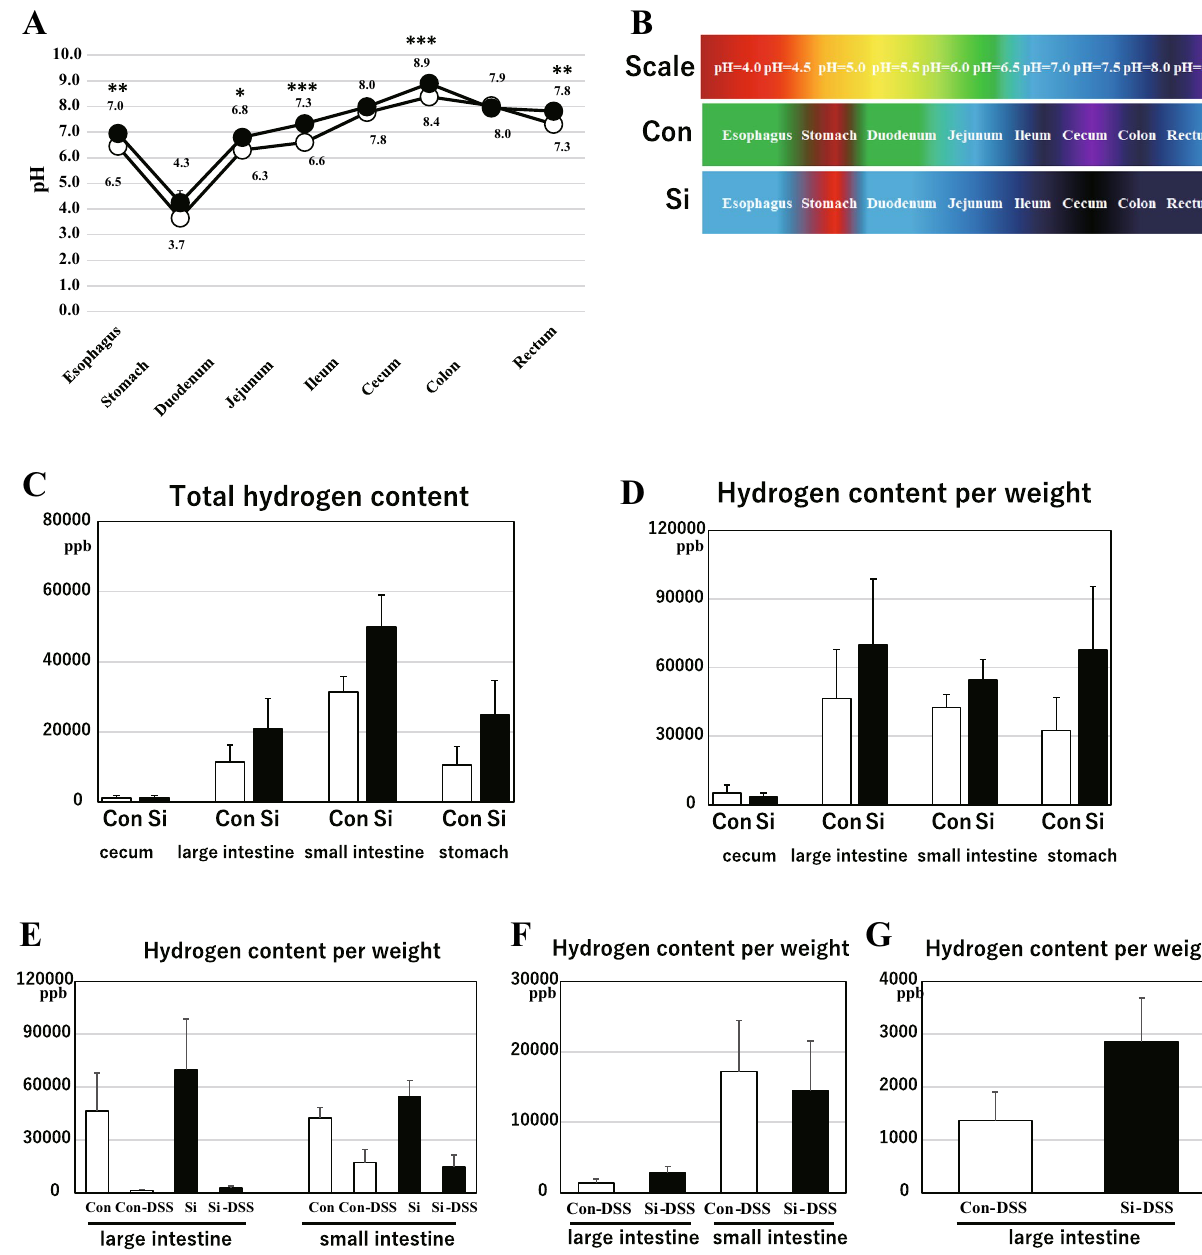
Figure 6. Si-based agents increased the amount of hydrogen in the large intestine. Detection of GI pH and hydrogen content. ( A ) The line graph for GI pH of the control group (white circle and dotted line) and Si group (black circle and solid line). The sections used for pH detection were the esophagus, stomach, duodenum, jejunum, ileum, cecum, colon, and rectum. Data are expressed as mean ± SEM of five mice per group. * p < 0.05, ** p < 0.01, *** p < 0.001 vs. control, determined by Student’s paired t -test. ( B ) Each pH variation is shown as color variation based on the scale. ( C – G ) The average bar graphs for gastrointestinal hydrogen content of the control or control DSS group (white bar) and the Si or Si-DSS group (black bar) in the normal state ( C , D ) and 3 days after 5% DSS treatment ( E – G ). ( C ) Total hydrogen content and ( D – G ) hydrogen content per weight. Data are expressed as mean ± SEM of nine mice and DSS-treated mice (Con: 8, Si: 7) per